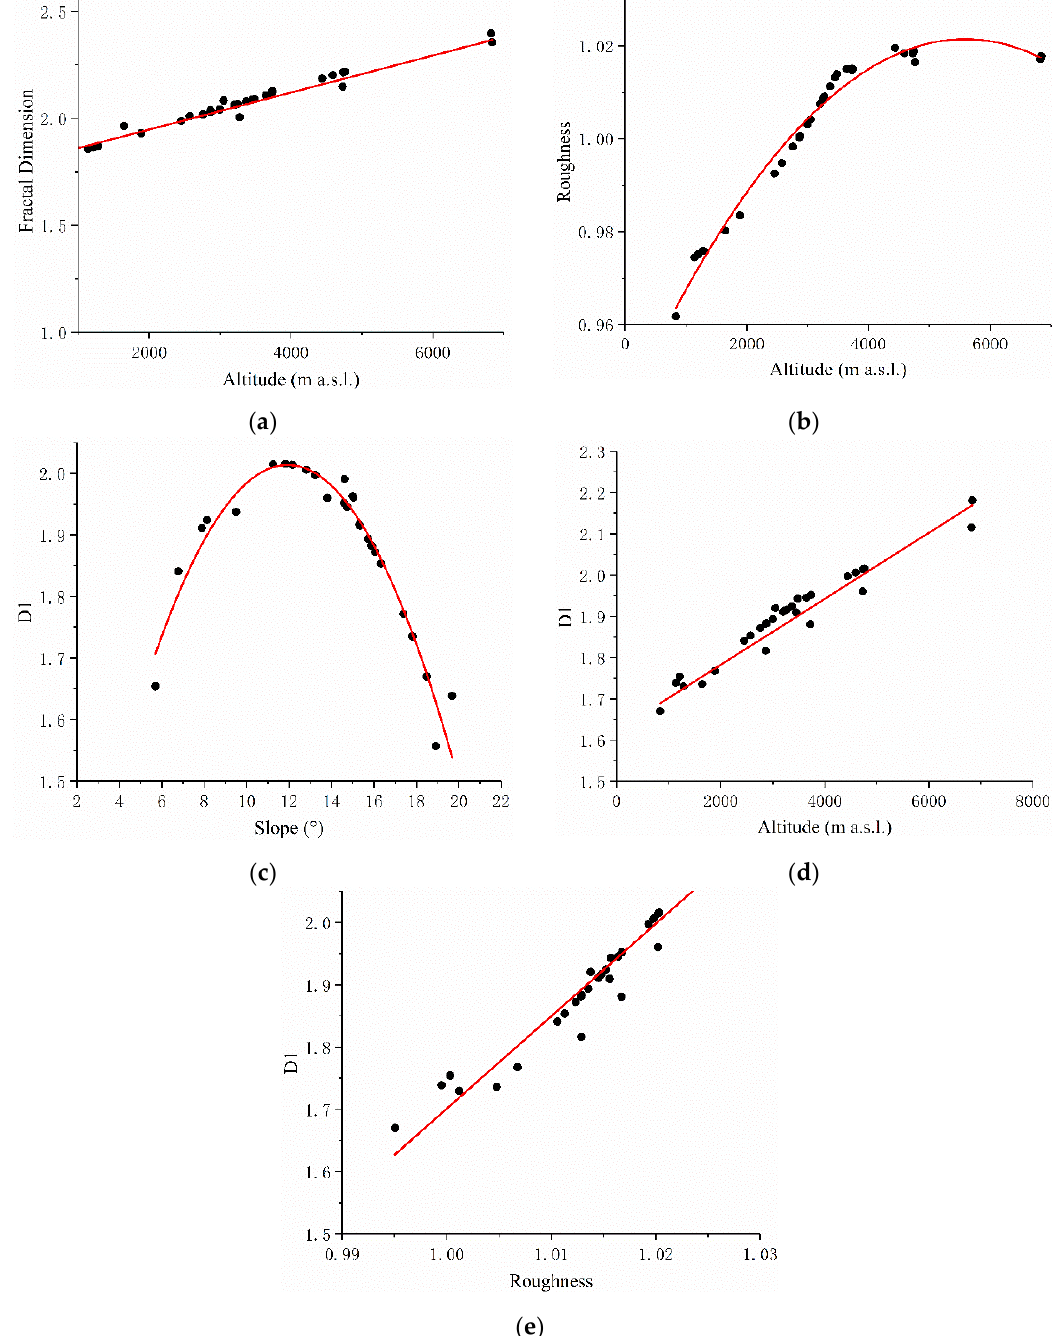
Figure 9. The correlation between ( a ) Altitude (m a.s.l.) and simple fractal dimension; ( b ) Altitude and topographic roughness; ( c ) Slope and information dimension; ( d ) Altitude and information dimension; and ( e ) Topographic roughness and information dimension. Table 4. Pearson ’ s correlation coefficients between general terrain parameters and other multifractal parameters. Topographic Slope